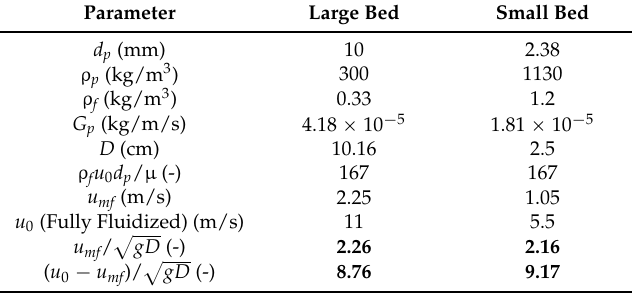
Table 2. Comparison of u 0 ´ u mf {